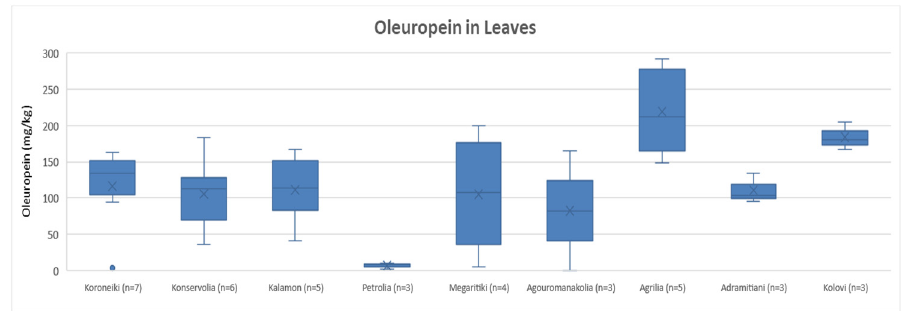
Figure 3. Box and whisker plot for the concentrations of oleuropein among different varieties of leaves. Tyrosol